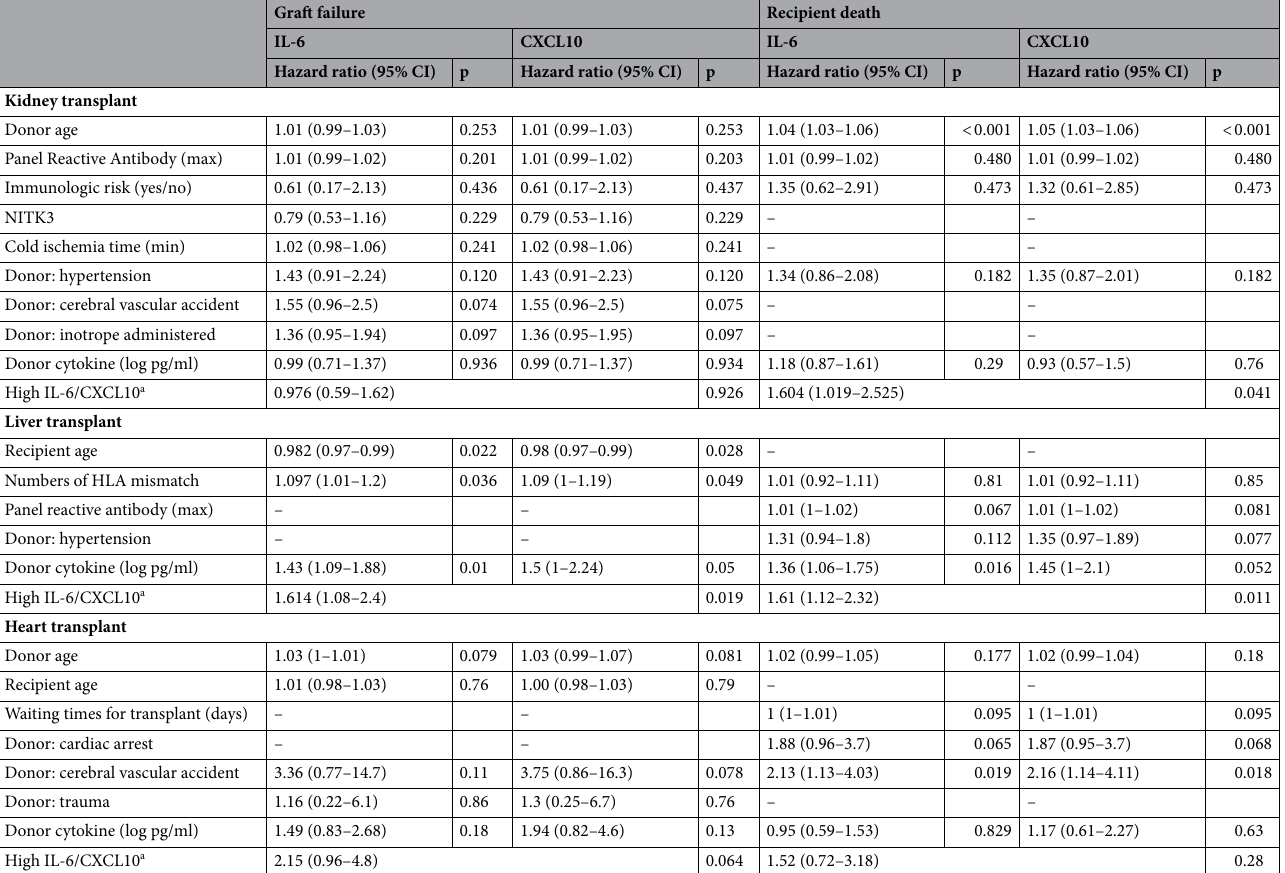
Table 3. Cox regression models of the predictors of graft failure and recipient death by multivariate analysis. For each cytokine, donor and recipient characteristics with p values < 0.05 in univariate analysis were included in the multivariate analysis. a Inserted instead of donor